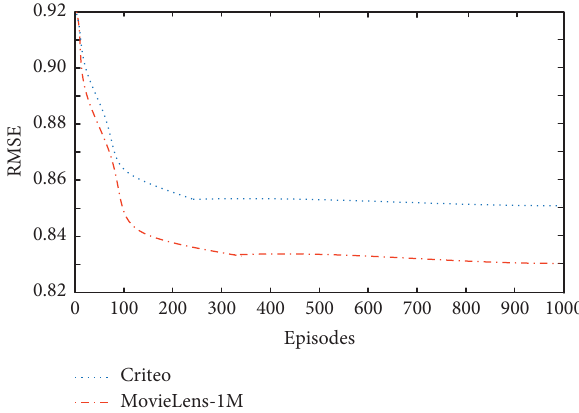
Figure 4: Efects of the number of iterations on RMSE.